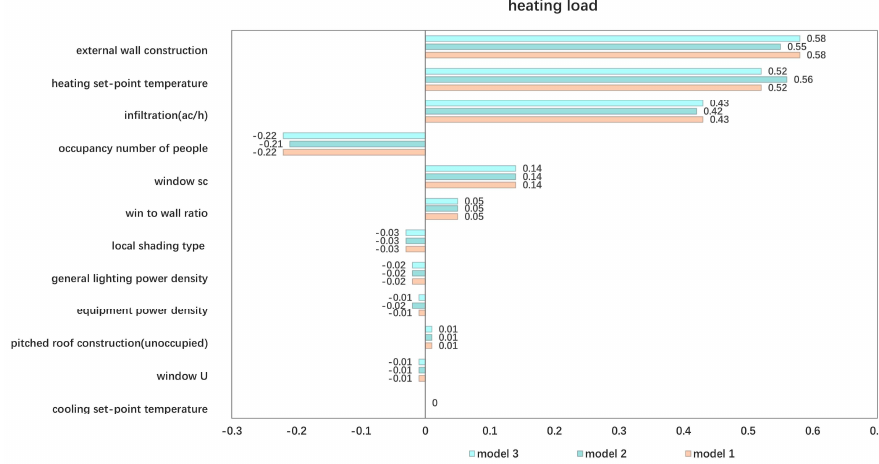
Figure 16. SRC of each parameter on electricity consumption.